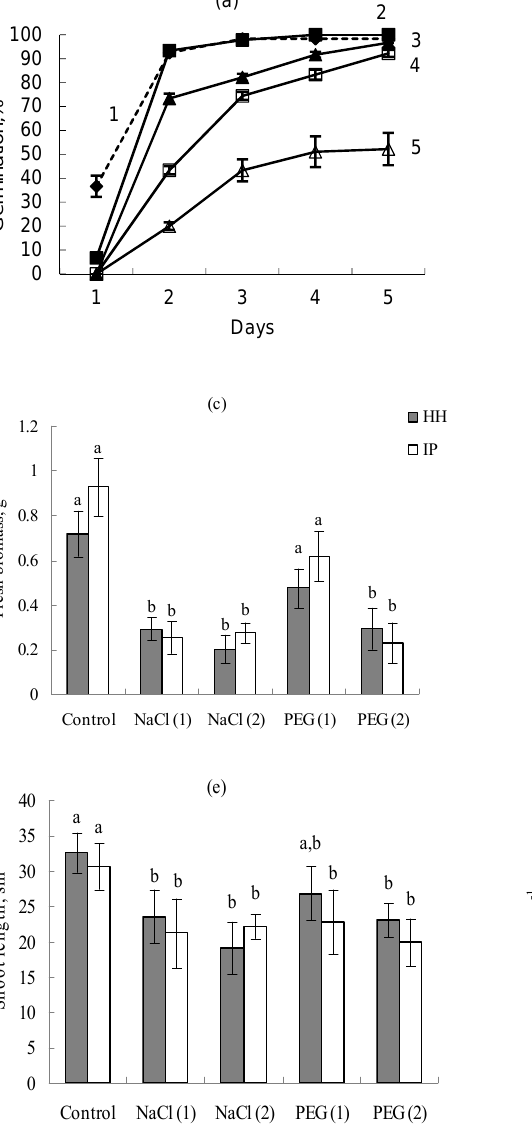
Figure 2. Seed germination rates and agrobiological characteristics of two genetic lines of pearl millet Pennisetum glaucum under different stresses. ( a , b ), ‘ HHVBC-Tall ’ ( a ) and ‘ IP 19586 ’ ( b ), under different salinity levels; 1, control (distilled water); 2, 100 mM NaCl; 3, 200 mM NaCl; 4, 300 mM NaCl; 5, 400 mM NaCl. ( c – f ), Effects of salt (NaCl) and osmotic (polyethylene glycol (PEG)) stresses on the fresh ( c ) and dry ( d ) biomasses, shoot lengths ( e ) and water contents ( f ) of leaves from these lines. HH, ‘ HHVBC-Tall ’ line; IP, ‘ IP 19586 ’ line; NaCl (1), 200 mM NaCl; NaCl (2), 300 mM NaCl; PEG (1), 15.8% ( m / v ) PEG 6000; and PEG (2), 18.8% ( m / v ) PEG 6000. The values are means ± SEs. Different letters above the bars represent significant differences at the p < 0.05 level (Tukey’s pairwise comparison). SEs—Standard Errors.